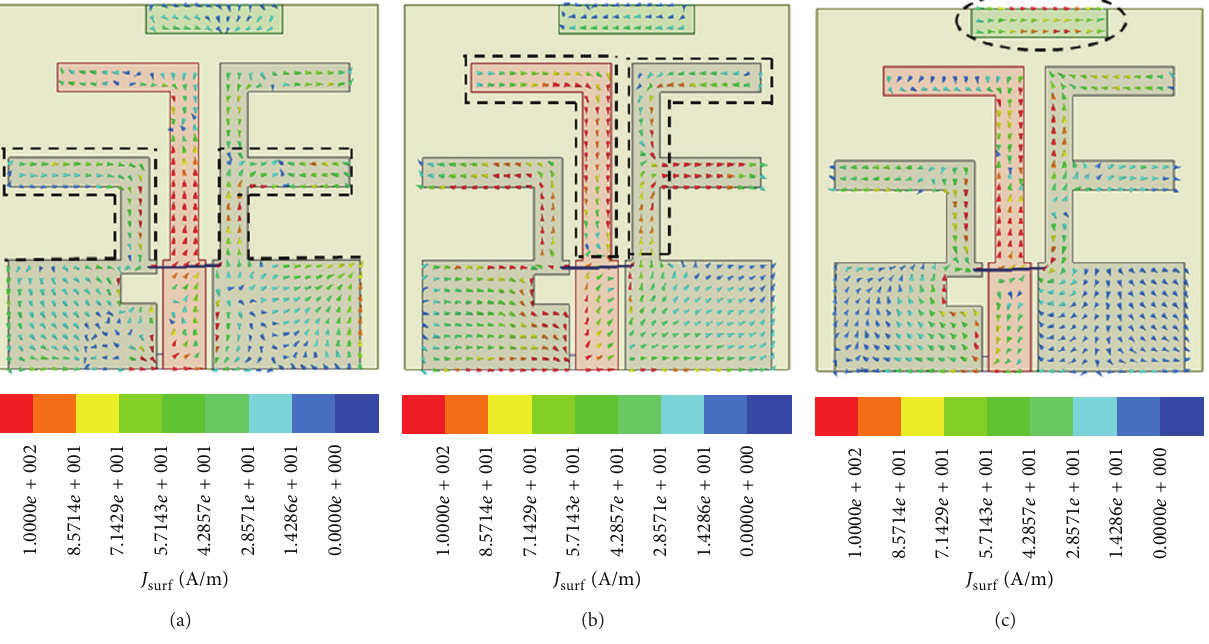
Figure 5: (a)–(c) The current distribution at 13.5, 30, and 60GHz,